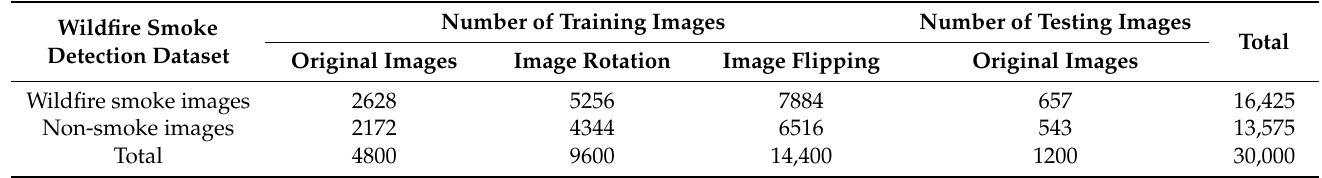
Table 2. Number of training and testing images in wildfire smoke dataset.